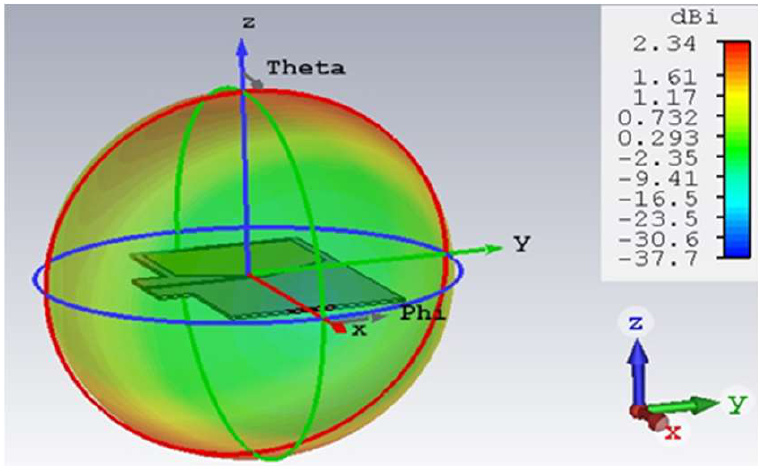
Figure 16. 3-D Simulated radiation pattern of the printed biconical antenna.